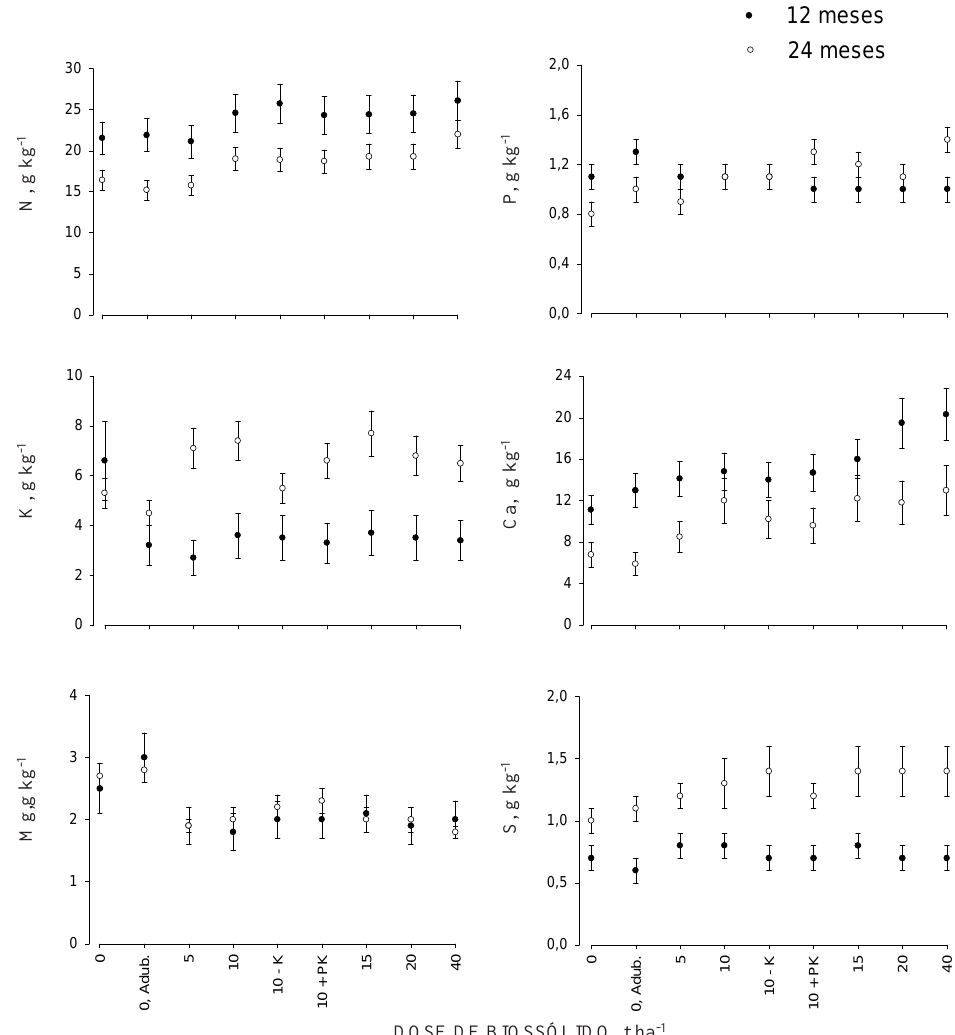
Figura 4. Concentração foliar de macronutrientes (média ± erro-padrão) aos 12 e 24 meses de idade das plantas de Eucalyptus grandis , 8 e 20 meses pós-aplicação do biossólido, em resposta às doses crescentes de biossólido, com suplementação de K (biossólido + KCl = 165 kg ha -1 de K), às aplicações de 10 t ha -1 de biossólido, sem suplementação de K e com suplementação de K e P, e à adubação mineral sem